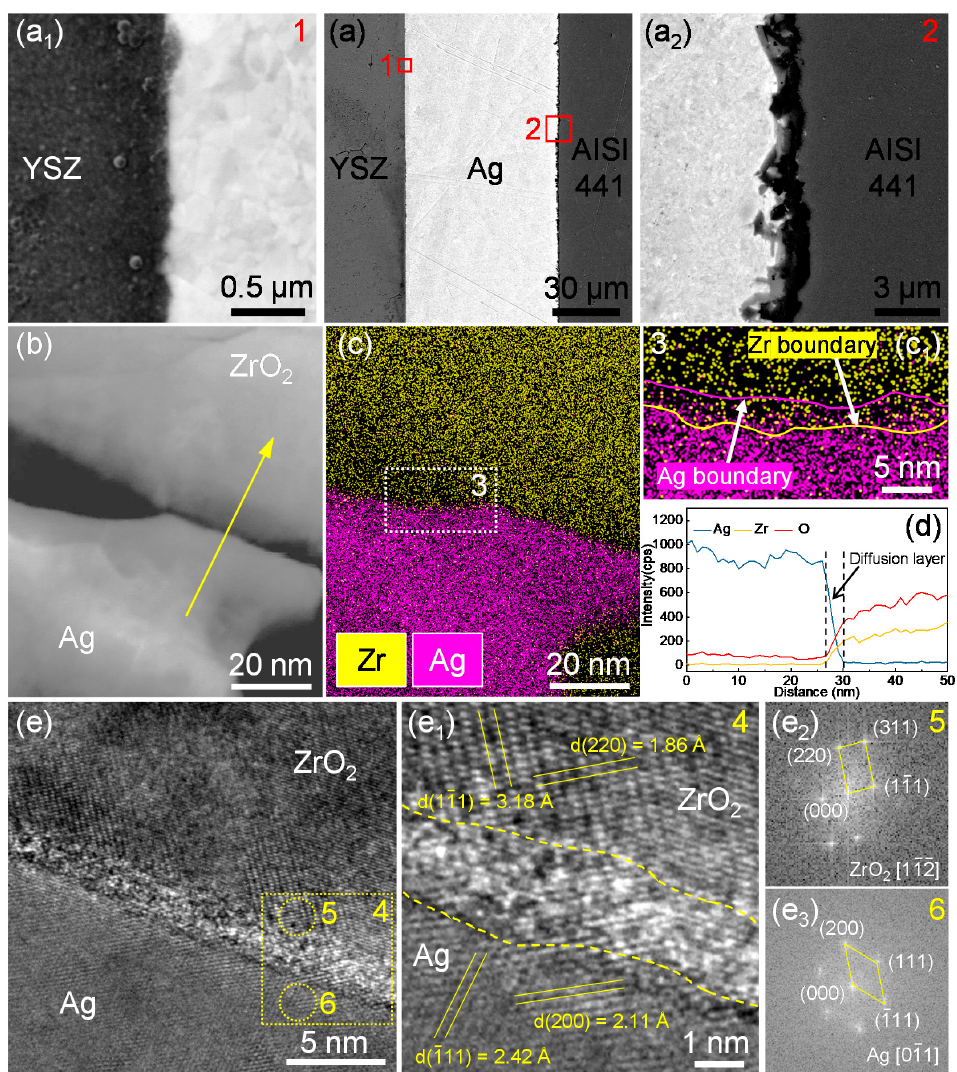
Figure 3. ( a ) Microstructure of YSZ/AISI 441 joint obtained at 920 °C, enlarged view at ( a 1 ) YSZ and ( a 2 ) AISI 441 interface; ( b ) bright-field image at the YSZ/Ag interface, ( c ) corresponding EDS mapping results, ( c 1 ) enlarged view of region 3, ( d ) elemental distributions along the yellow line, ( e ) HRTEM image at YSZ/Ag interface, ( e 1 ) enlarged view of region 4, selected area diffraction patterns of ( e 2 ) region 5 and ( e 3 ) 6.